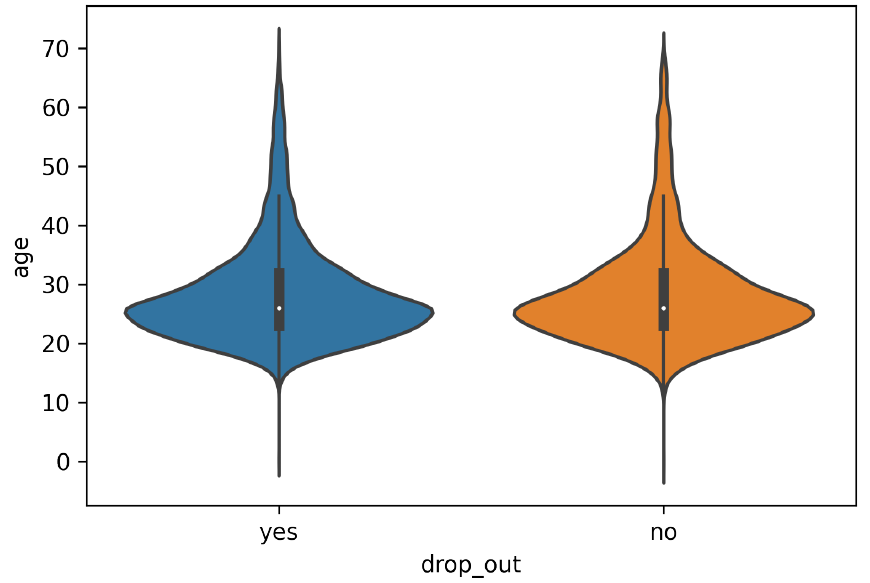
Figure 5. Violin plot of dropout and age